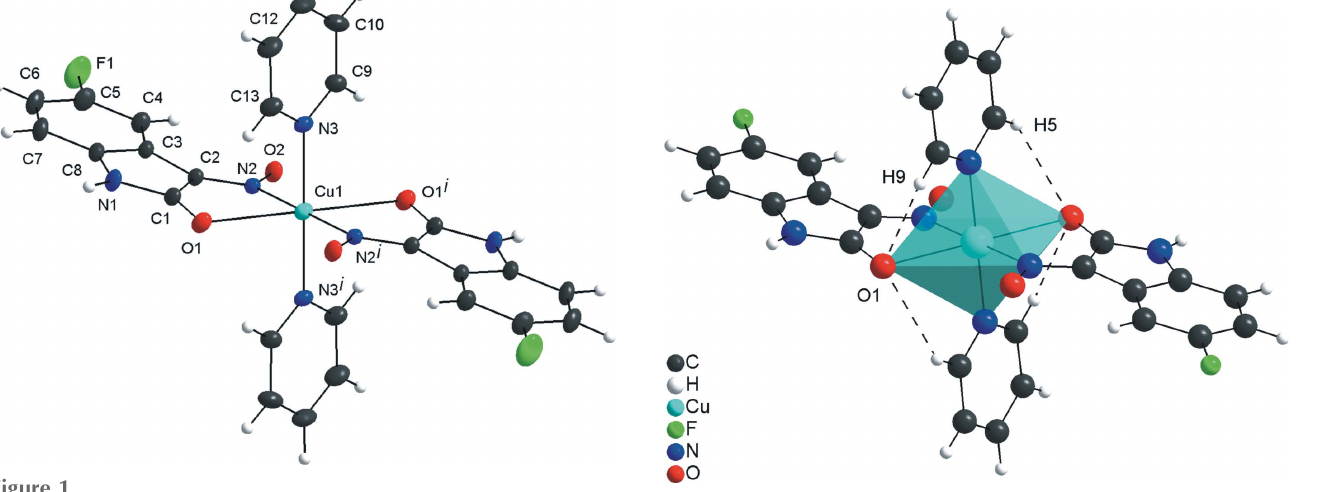
Figure 2 The intramolecular C—H (cid:2)(cid:2)(cid:2) O hydrogen interactions of the title compound (dashed lines) forming a ring of S (5) graph-set motif.